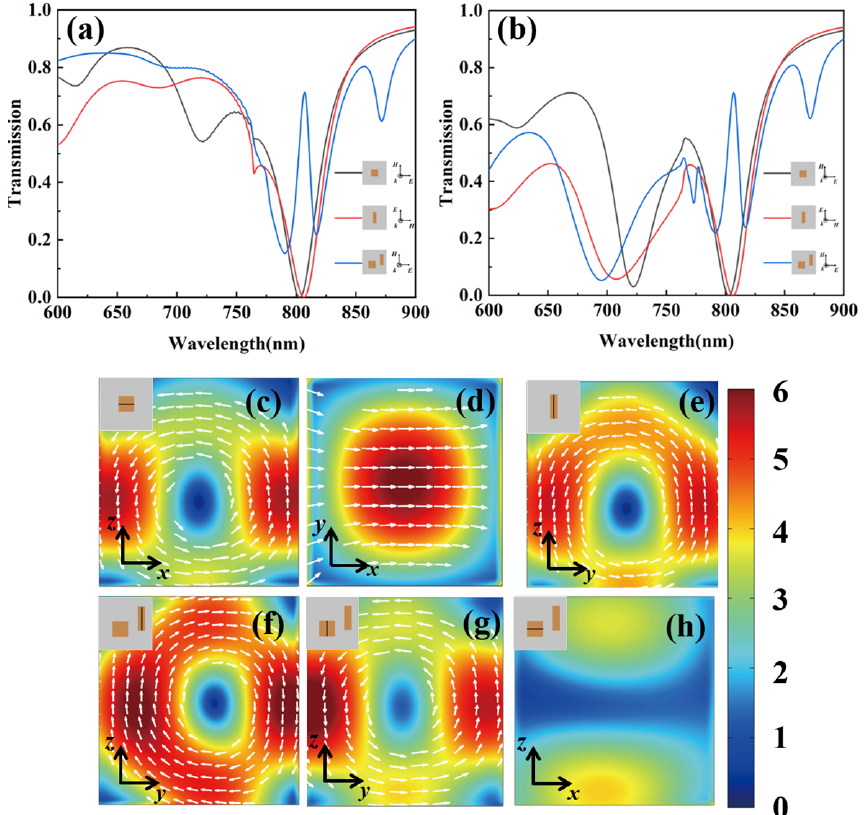
Figure 3. Simulated transmission spectrum for sole-cuboid nanostructure metasurface, sole-bar nanostructure metasurface and bidirectional EIT metasurface with f = 100 nm and g = 200 nm under forward incidence ( a ) and backward incidence ( b ). Distribution of electric field in x-z plane inside the cuboid of the sole-cuboid nanostructure metasurface at 803 nm ( c ), in x-y plane inside the cuboid of the sole-cuboid nanostructure metasurface at 722 nm ( d ), in y-z plane inside the bar of the sole-bar nanostructure metasurface at 806 nm ( e ). Distribution of electric field in y-z plane inside the bar ( f ), in y-z plane inside the cuboid ( g ), and in x-z plane inside the cuboid ( h ) of the near-infrared bidirectional EIT metasurface at the EIT peak. The magnetic dipole moments in the bidirectional EIT metasurface are calculated from the displacement currents simulated by FDTD. The magnetic dipole moment m 1 in cuboid ( x component of the magnetic dipole), which relates to bright mode, reaches minimum at 809 nm, shown by red curve in Figure 4, whereas the magnetic dipole moments m 2 in bar and m 3 in cuboid ( y component of the magnetic dipole), which relate to dark mode, both exhibit a peak at 810 nm, as shown by black curve and blue curve in Figure 4, respectively. The maximum of the magnetic dipole moments m 2 and m 3 corresponds to the minimum of the magnetic dipole moment m 1 , that is, the enhancement of the dark mode is accompanied by the decrease of the bright mode. The electromagnetic energy is transferred from the bright mode m 1 into the dark modes m 2 and m 3 due to the near-field coupling, resulting in the dip of m 1 and the peak of m 2 and m 3 . The destructive interference between bright and dark modes results in the EIT phenomenon in cuboid-bar